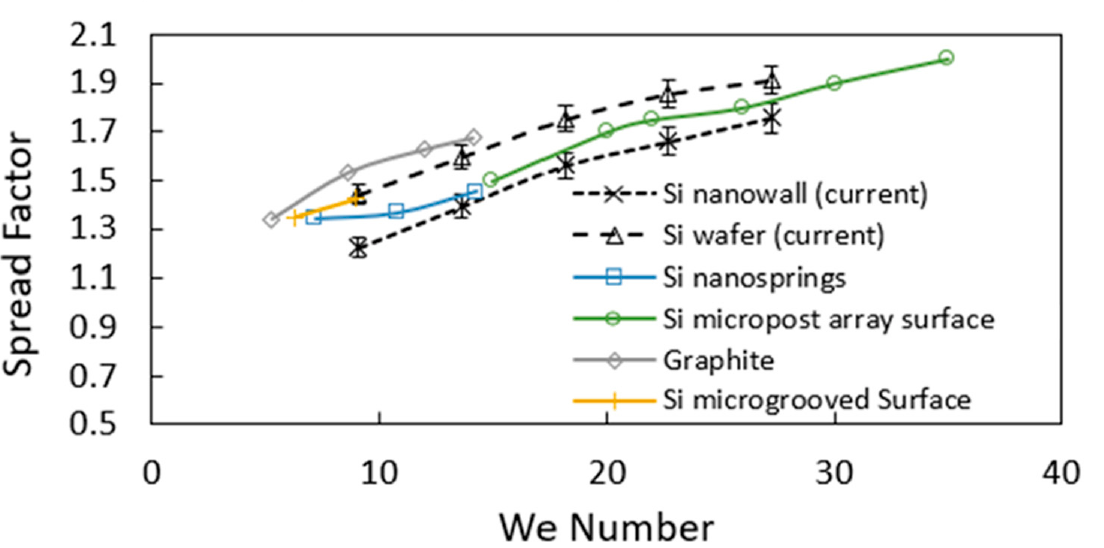
Figure 7. Comparison of spreading factor with Weber number for different surface types. □ Si nan ‐ osprings Adapted from Ref. [46]; ○ Si micropost array surface Adapted from Ref. [47]; ◊ Graphite Adapted from Ref. [48]; | Si microgrooved Surface Adapted from Ref. [13].